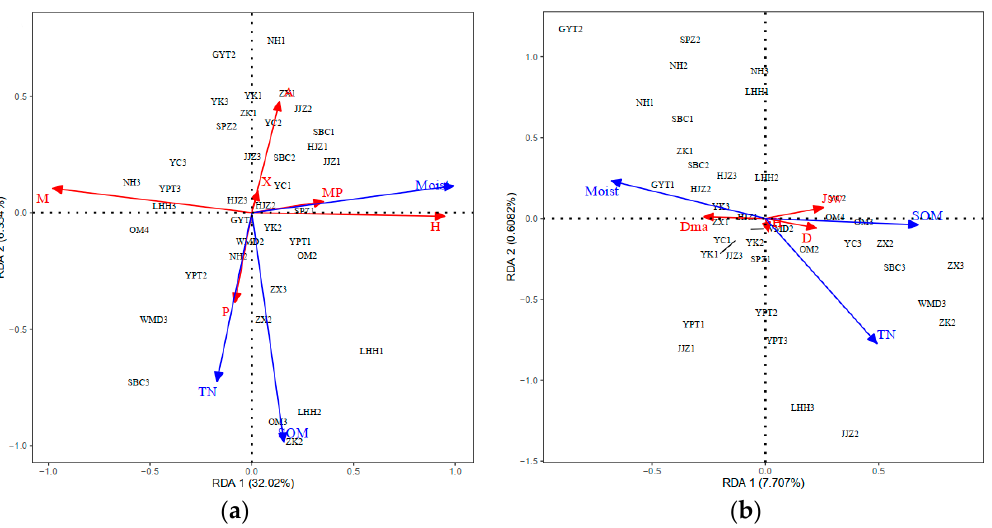
Figure 5. RDA of edaphic factors and species hydrophilic, life history, and species diversity in the MLHR. ( a ) RDA ordination diagram of the edaphic factors and the vegetation types; ( b ) RDA ordination diagram of the edaphic factors and the diversity indices of different transects. Based on the analysis of three sequence diagrams, the long arrow represents the edaphic factor, and the length of the arrow indicates its effect on plant size. Species and edaphic factors represented the cosine value